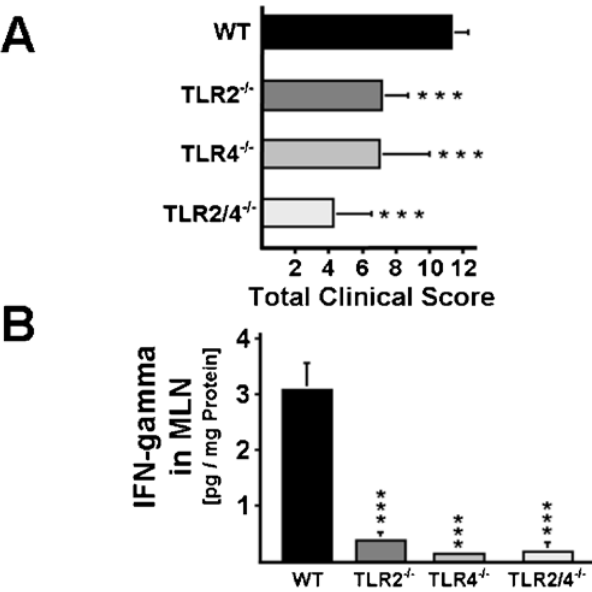
Figure 1. Colitis severity and inflammatory responses in TLR2 -/- , TLR4 -/- , and TLR2/4 -/- mice, as compared to wt controls. ( A ) Severity of colitis in DSS-treated animals. Clinical outcome of colitis was recorded in wt mice (WT, n=10) and in mice lacking TLR2 (TLR2 -/- , n=10), TLR4 (TLR4 -/- , n=12), or both (TLR2/4 -/- , n=11). Clinical parameters of colitis were monitored daily (see methods). The data sets from two independent experiments were pooled. Total colitis scores were analyzed at day eight after DSS-treatment for seven days. ( B ) IFN-gamma concentrations in supernatants of colonic MLN cultures from wt and TLR-deficient animals. Supernatants from MLN cultures of wt mice (WT, black bars, n=3), and animals lacking TLR2 (TLR2 -/- , n=4), TLR4 (TLR4 -/- , n=5), or both (TLR2/4 -/- , n=4) with colitis were analyzed at day eight after DSS-treatment for seven days. ( A/B ) Mean values, standard deviations and significance levels (as compared to the wt animals) determined by Student’s t-test are indicated ( *** , P ,